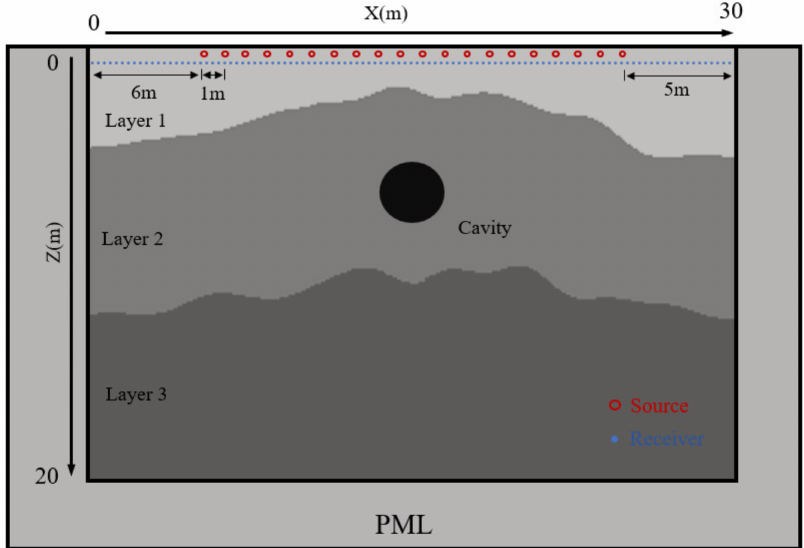
Figure 7. Sketch map of the geological model.